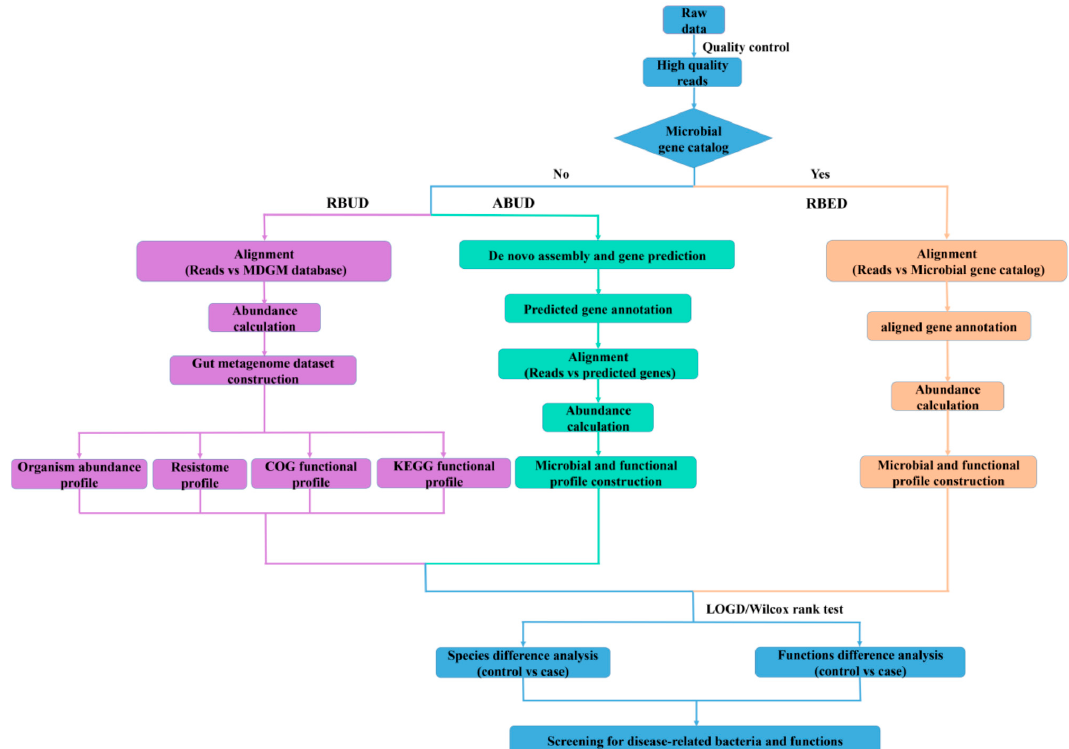
Figure 1. Flow chart of the read-based metagenomics profiling for unestablished database (RBUD) method, the assembly-based metagenomics profiling for unestablished database (ABUD) method and the read-based metagenomics profiling for established database (RBED) method to analyze metagenomic data in this study. The blue box represents the common steps of all methods. The purple box represents the steps of RBUD method. The light green box represents the steps of ABUD method, and the orange box represents the steps of RBED method.